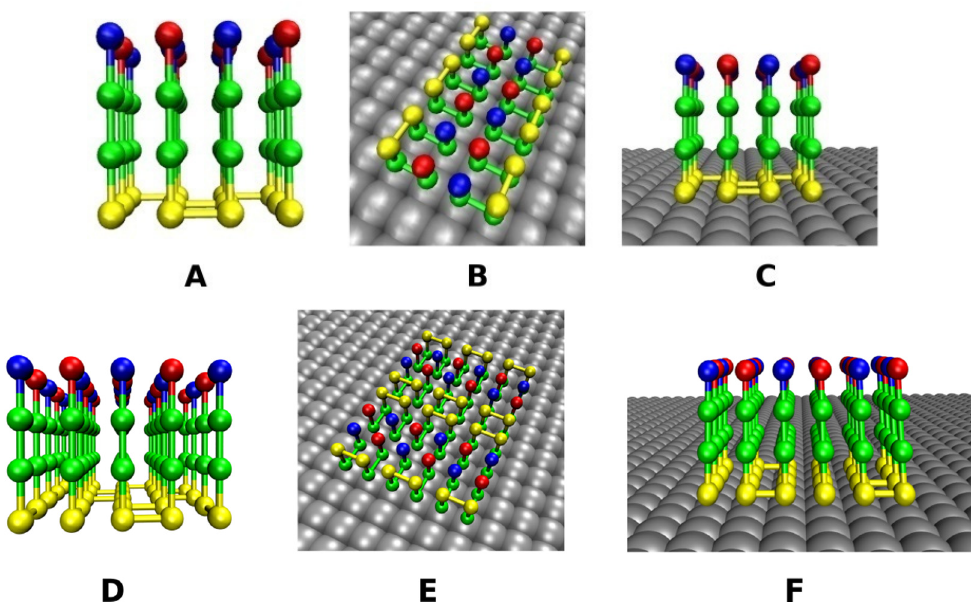
Figure 2. Fibril structure of six polypeptide chains in bulk ( A ), on hydrophobic surface ( B ) and hydrophilic surface ( C ). Fibril structure of 12 polypeptide chains in bulk ( D ), on hydrophobic surface ( E ) and hydrophilic surface ( F ).